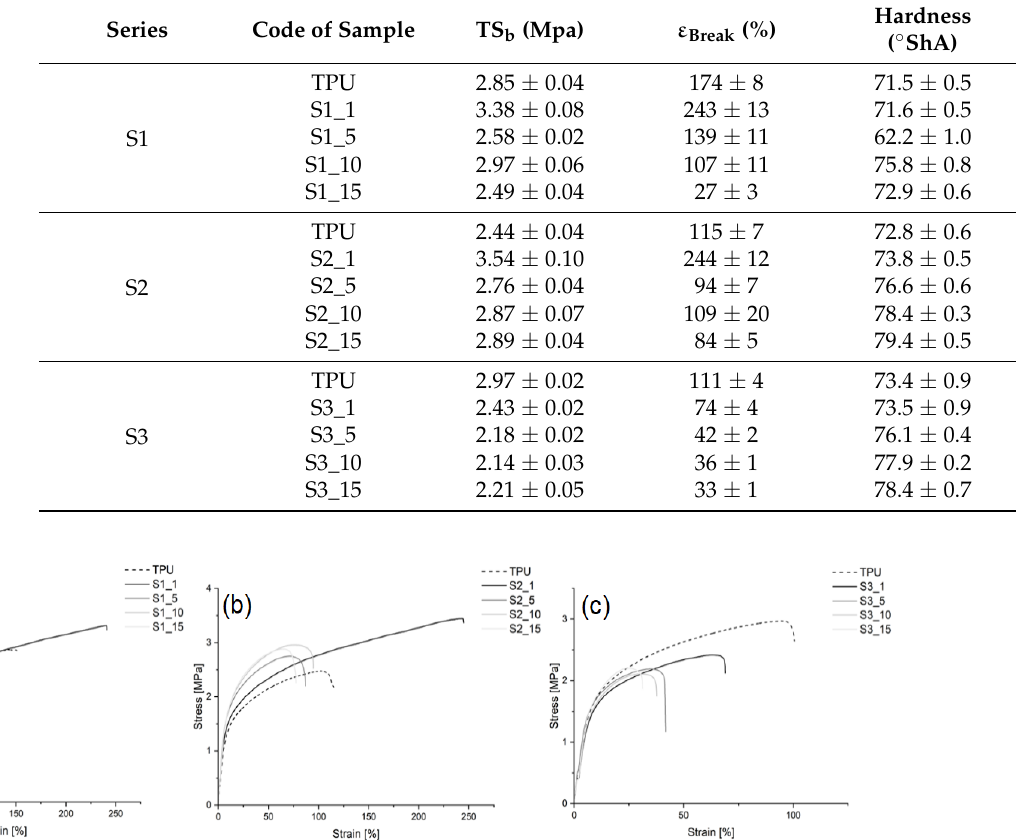
Figure 8. Stress-strain curves for the tested bio-TPUs matrices and bio-TPU – ABW composite series ( a ) series S1, ( b ) series S2 and ( c ) series S3. ( a ) series S1, ( b ) series S2 and ( c ) series